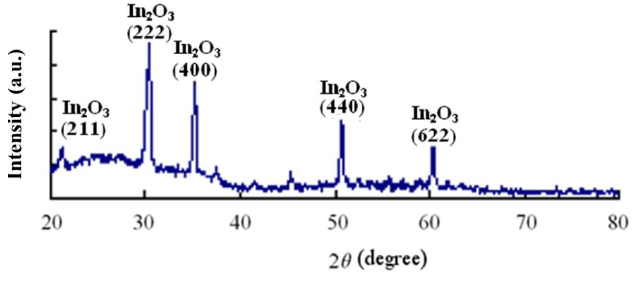
Figure 4. XRD diffraction pattern of deposited WO Target, W (99.99% purity); RF power, 200 W; argon flow rate, 15 sccm; oxygen flow rate, 15 sccm; working pressure, 0.01